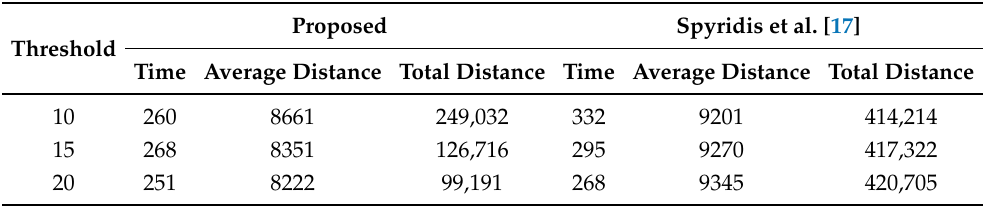
Table 2. Average results for all values of the standard deviation σ of the additive noise for the DL method and the previous approach, at different thresholds. The target is placed at a 2 km distance. Time is measured in seconds and distance in meters.